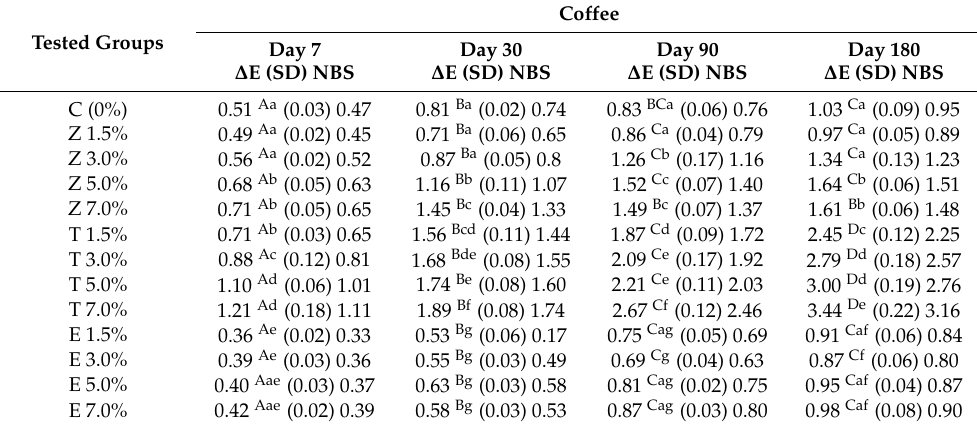
Table 5. Results of the two-way RM-ANOVA with descriptive statistics of ( ∆ E) and National Bureau of Standards (NBS) unit at four different time intervals for each group after immersion in coffee.